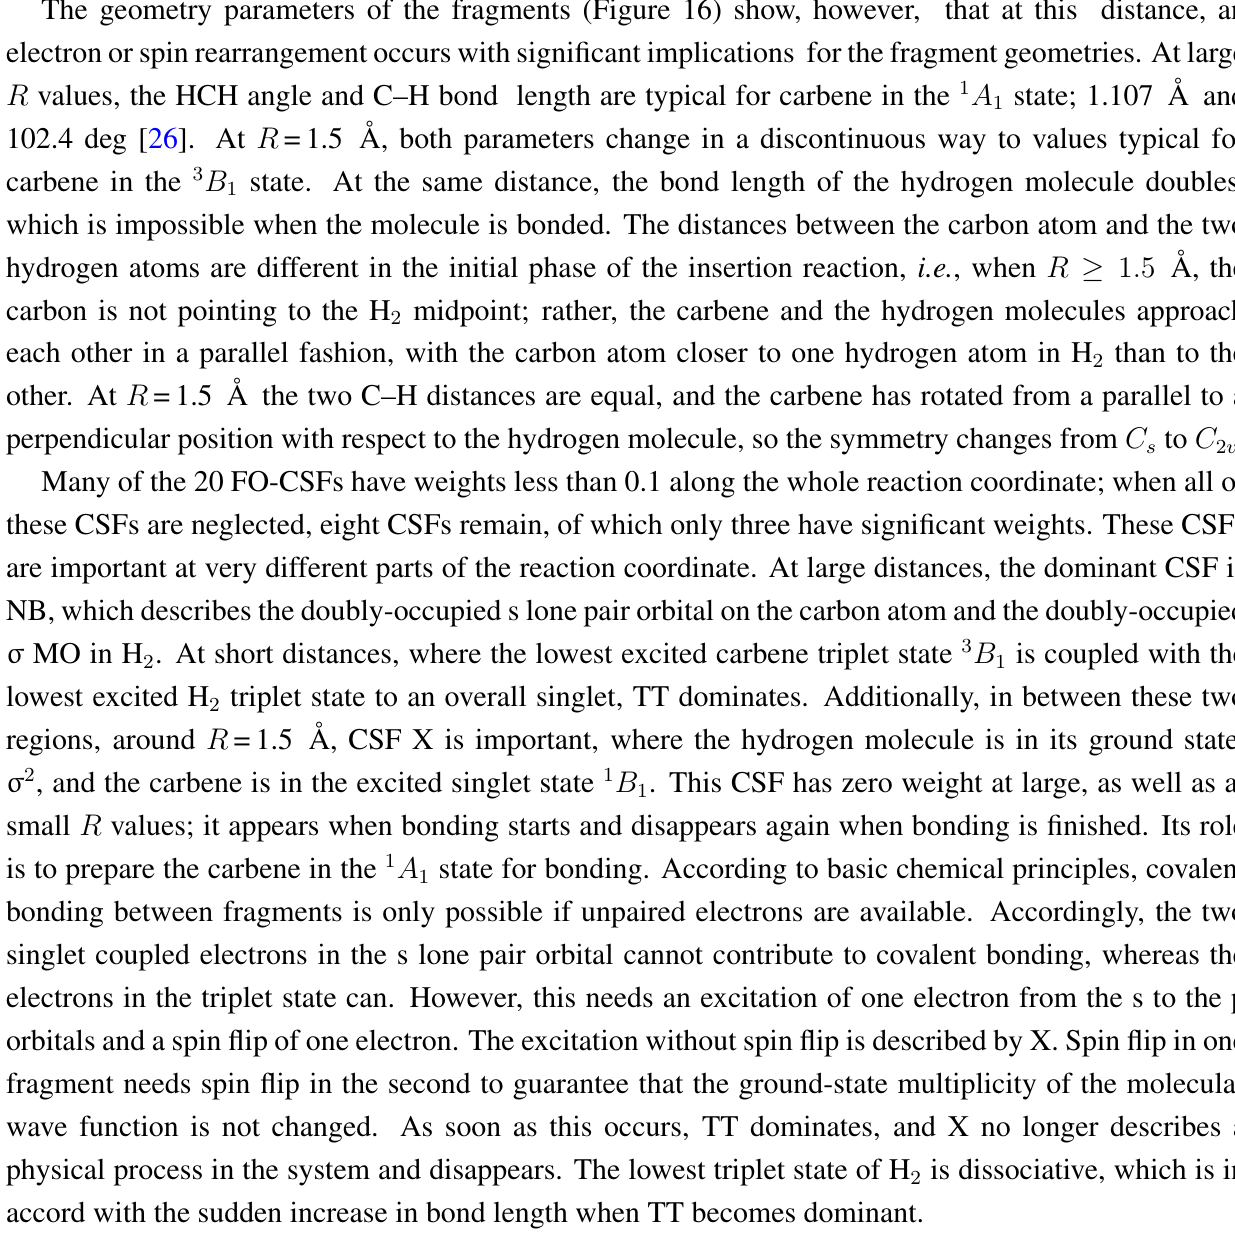
Figure 15. Carbene insertion into H